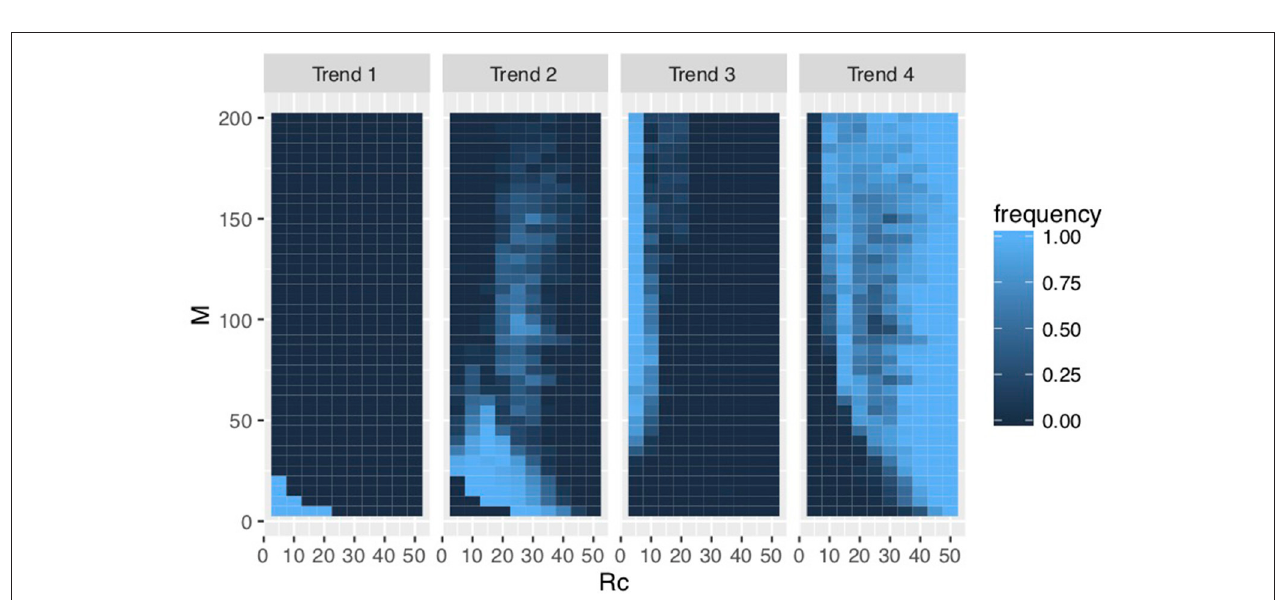
FIGURE 3 | Summary of results of evolutionary simulations. We found four evolutionary trends ( s and q of the final populations) depending on total resources R c M and the ratio of each cooperator’s resources to the number of cooperators R c / M (see details Figure 4 , Figures S1, S2). (A) Shows the results of evolution with parameter R c and M . Each color shows the most frequent trend in parameters of the point. This was created based on Figure 4 . (B) Is the concept diagram. Trend 1 evolved when R c M was small. Trend 4 evolved when R c M was large. Trends 2 and 3 evolved in the intermediate range between trends 1 and 4 where R c / M determined whether groomers evolved to trend 2 or 3. The behavior of trends 2 and 3 were similar to human strategies, although trend 2 was closer, as described.